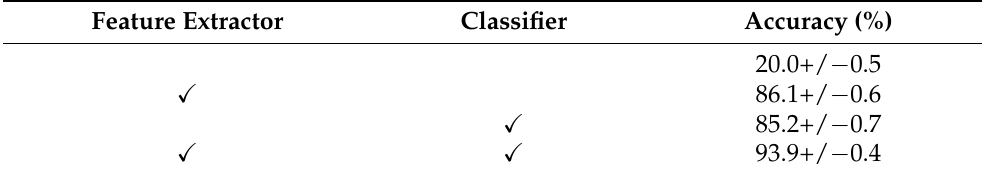
Table 5. Ablation studies of LFM-CNAPS on an Out-of-Domain Miniplantdisease-Dataset.